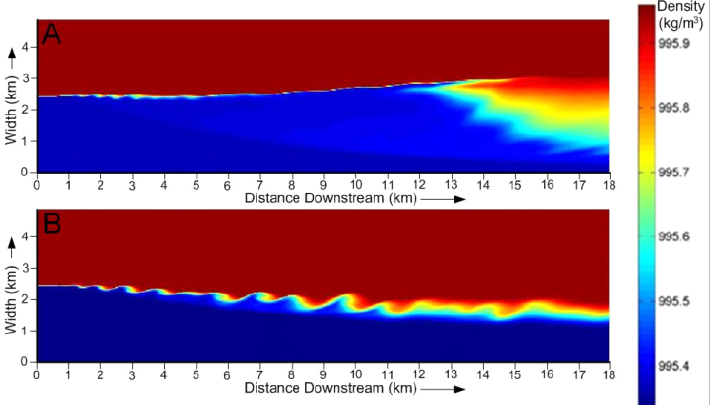
Figure 9. ( A ) Top view of the base scenario where the different colors indicate different densities. (red = dense, blue = light) Flow from left to right. ( B ) Same view for a situation with 1/4 of the density